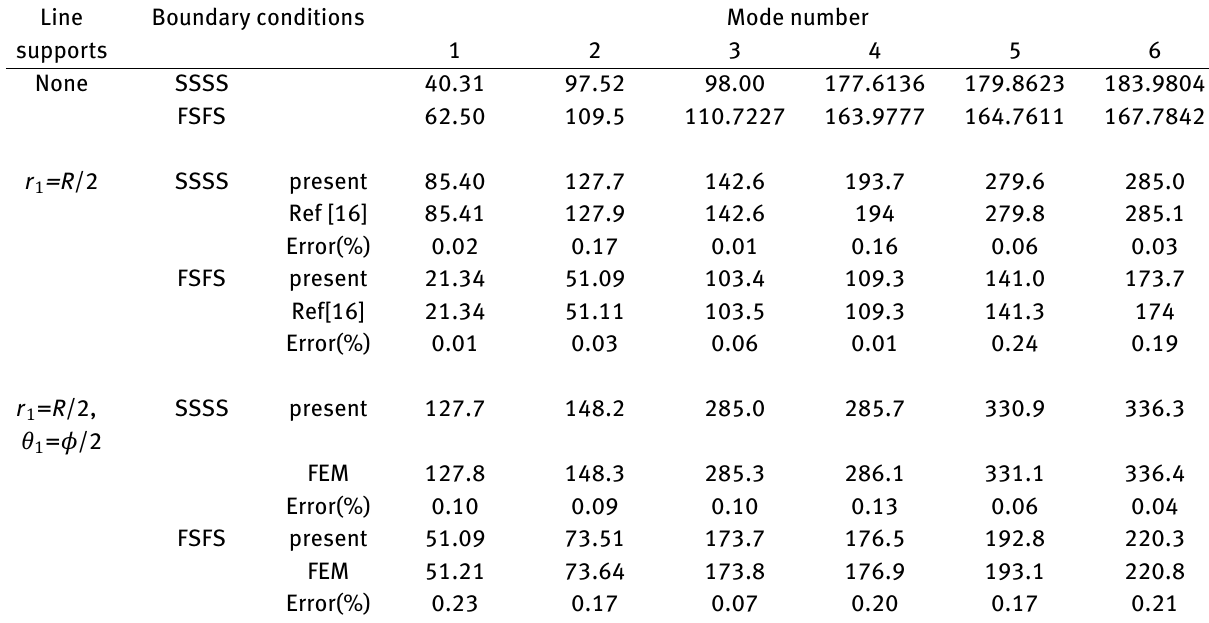
Table 8: Comparison of the first six frequency parameters Ω = ω b 2 ( ρ h / D ) 1/2 for a isotropic annular sector plates with h /b = 0.001(thin plate), a / b =0.2 and ϕ = π